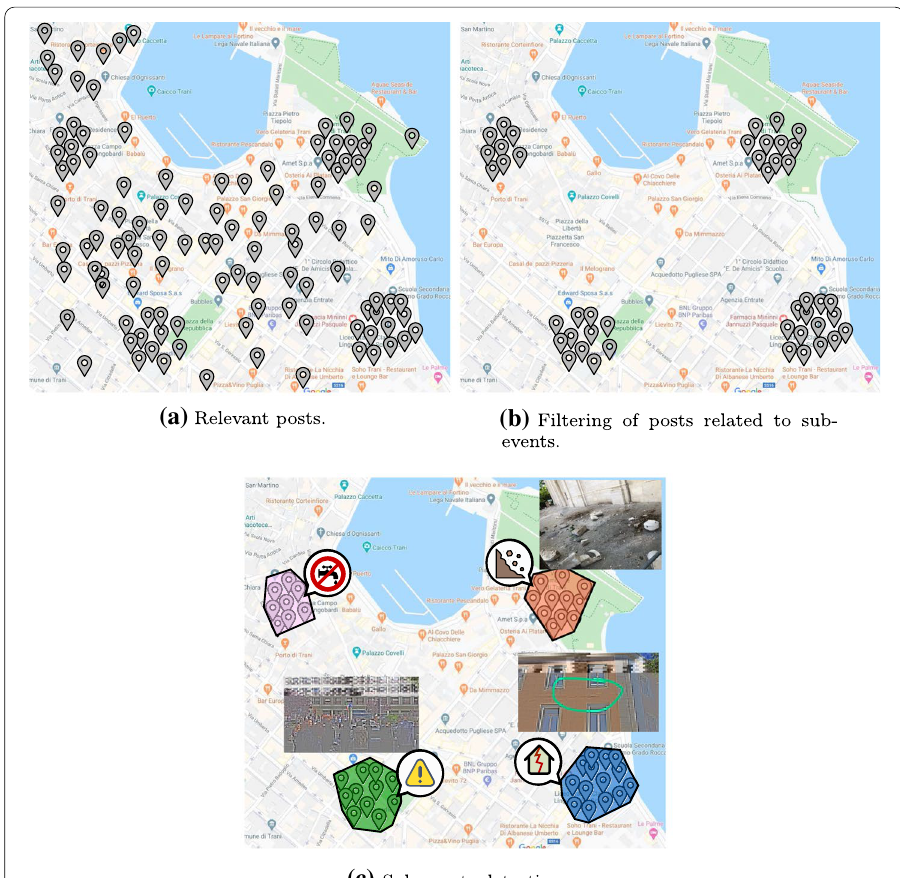
Fig. 2 An example of using SEDOM-DD on posts collected during the earthquake in the old town of Trani (May 21,